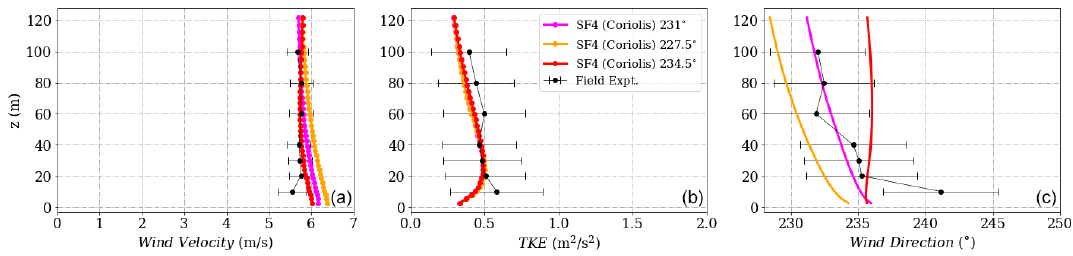
Figure D7. (a) Wind velocity magnitude, (b) wind direction and (c) turbulent kinetic energy tuned to reach calibration at height 573m corresponding to 100m at Tower 20 (tse04) for the SF4 (Coriolis) model.